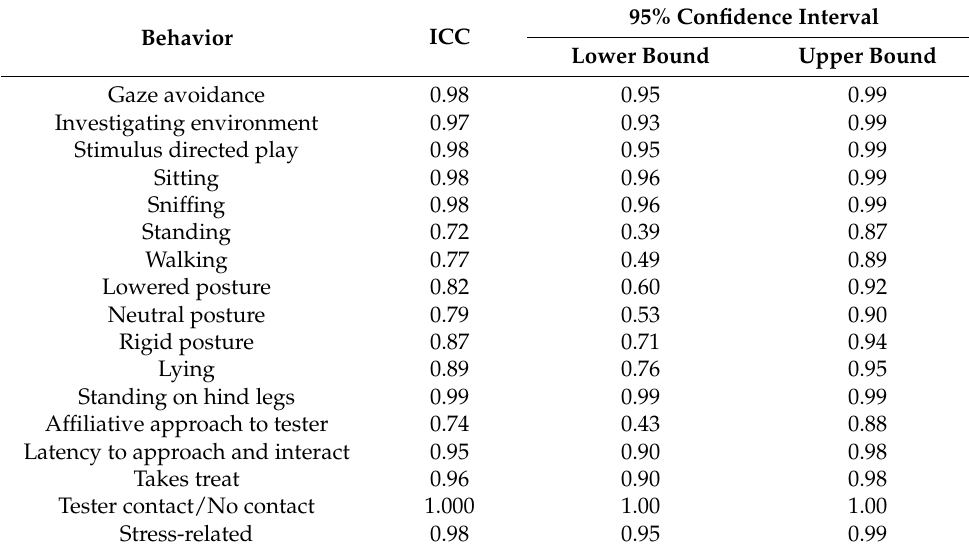
Table 3. Intraclass Correlations Coefficient (ICC) for analyzed behaviors. Values listed are ICC values and the lower and upper bounds of the 95% confidence interval